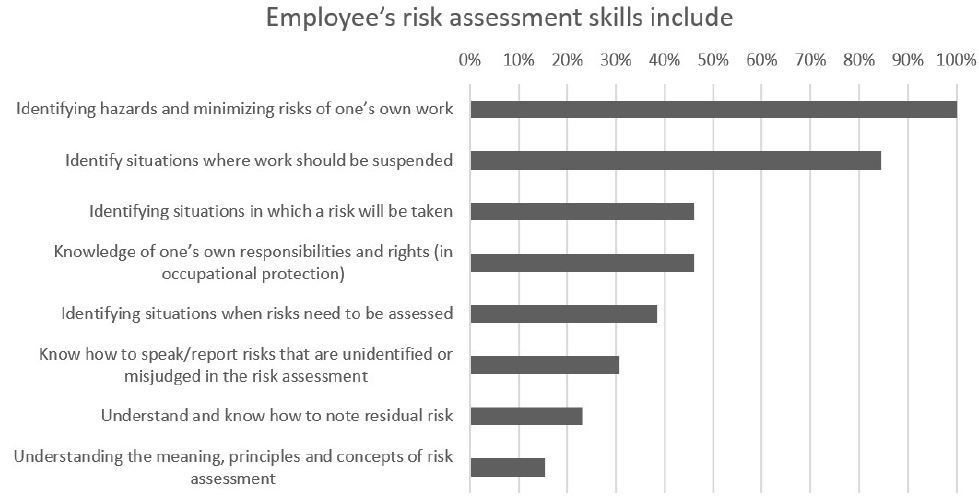
assessment skills needed by the Figure 1. Opinions of occupational health specialists and managers on the most important risk as- sessment skills needed by the employee.